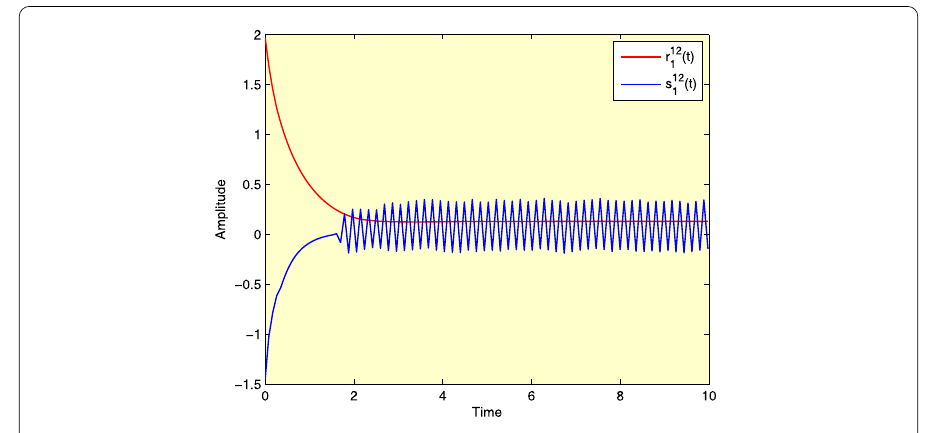
Figure 10 Time responses of state variables r 12 1 ( t ), s 12 1 ( t ) of NN models (1) and (3)